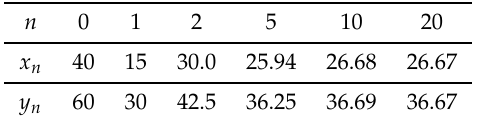
Table 4. Values of the iterated sequence ( x n , y n ) if started with ( 40,60 ) . n